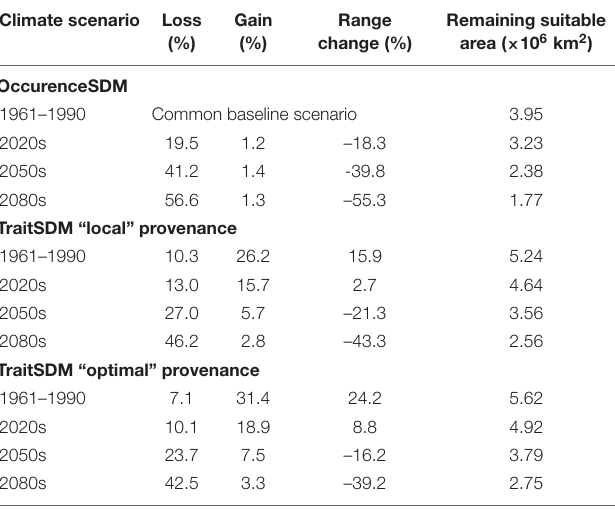
TABLE 6 | Species range change predicted by OccurrenceSDM and TraitSDM using “local” or “optimal” provenances. Climate scenario Loss